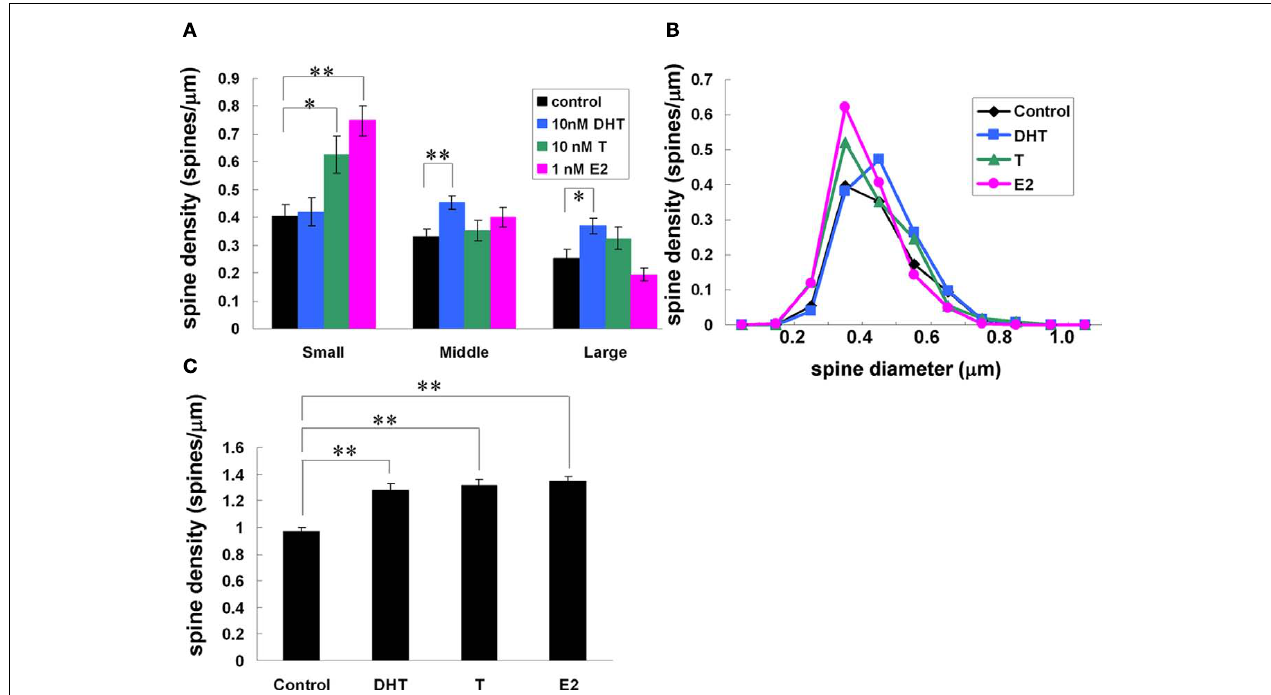
and E2. From left to right, ACSF without hormones (black), 10nM DHT (blue), 10nMT (green), and 1nM E2 (pink). (B) Histogram of spine head diameters. After a 2-h treatment in ACSF without steroids (Control, black), E2 (pink),T (green), and DHT (blue). (C) Total spine density.Vertical axis is the average number of spines per 1 μ m of dendrite. Modified from Mukai et al.